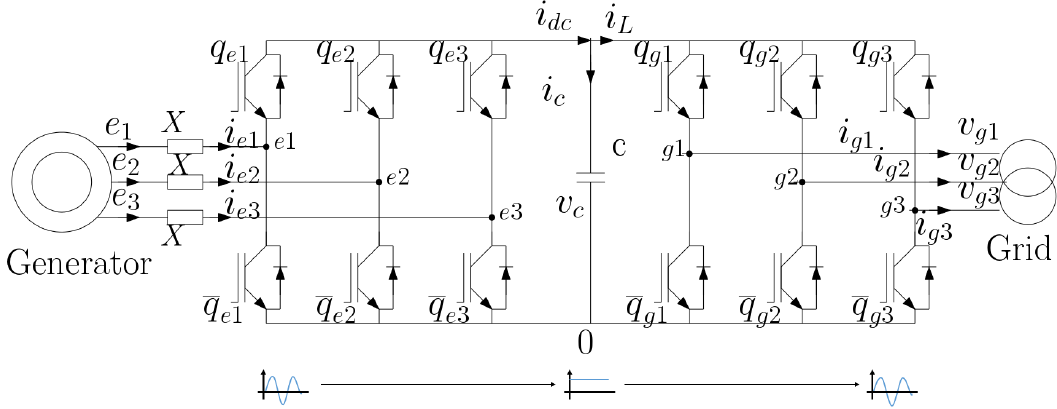
Figure 28. Switch representation of the three-phase to three-phase back-to-back converter, adapted from [138].